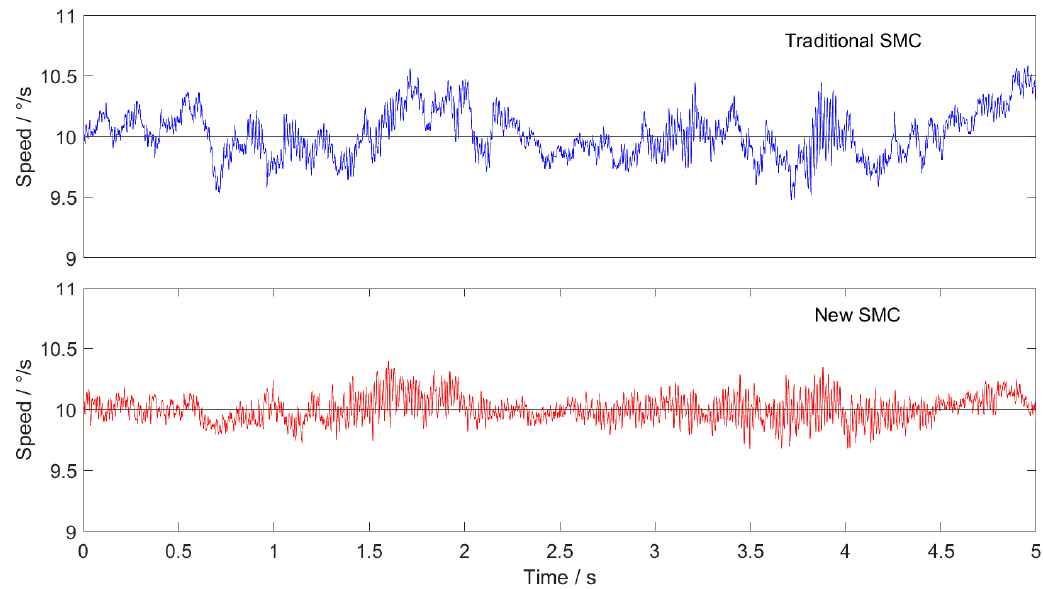
Figure 7. Tracking curve of uniform speed.